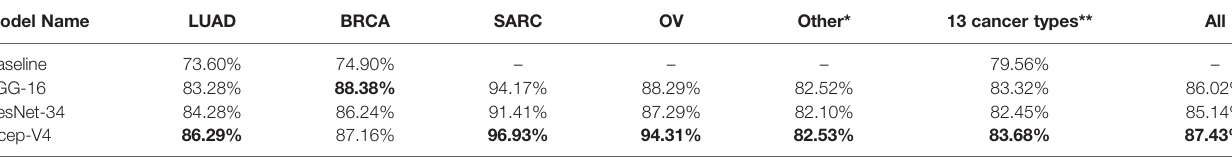
TABLE 1 | Evaluation of patch classi fi cation